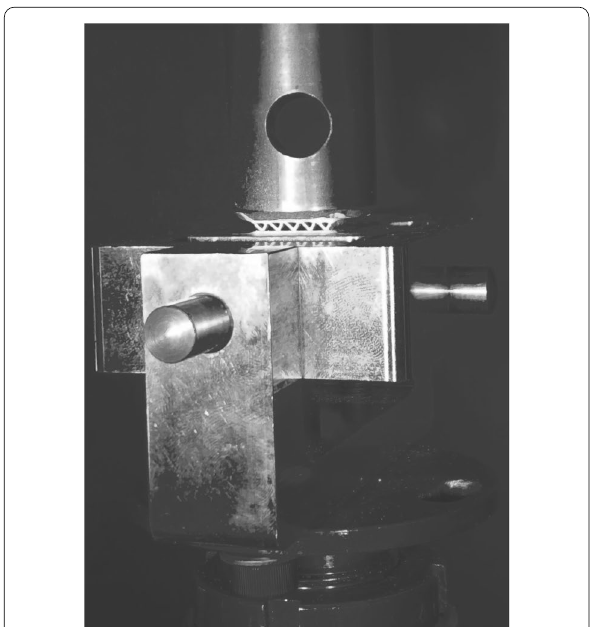
Figure 5 Final test set‑up for out‑of‑plane tensile tests